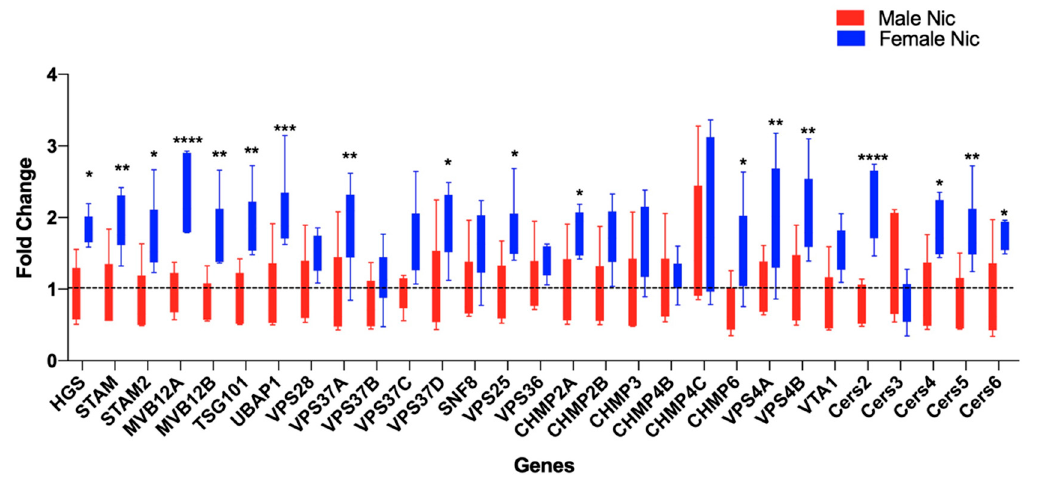
Figure 4. Chronic nicotine treatment increases the biogenesis and the expression of ESCRT dependent and independent pathway proteins. A custom qRT-PCR panel for EV biogenesis genes revealed several genes involved in the ESCRT dependent (complexes 0, I, II, and III) and independent pathways to be significantly upregulated in the females post nicotine self-administration. Data represented as mean ± SEM, n = 4–6 animals per group, **** p < 0.0001, *** p < 0.001, ** p < 0.01, * p < 0.05 (adjusted p value) as determined by a multiple t-test followed by Holm–Sidak